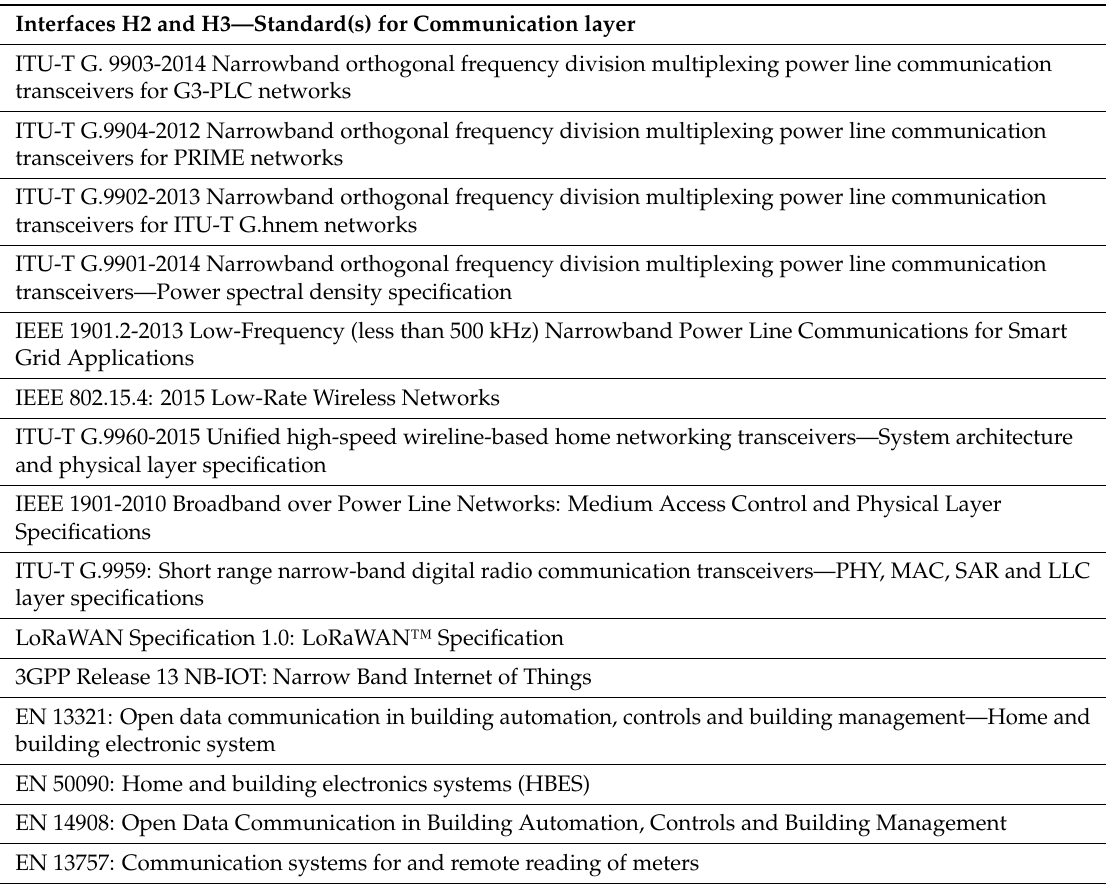
Table 6. Interfaces H2, H3 and standards for the communication